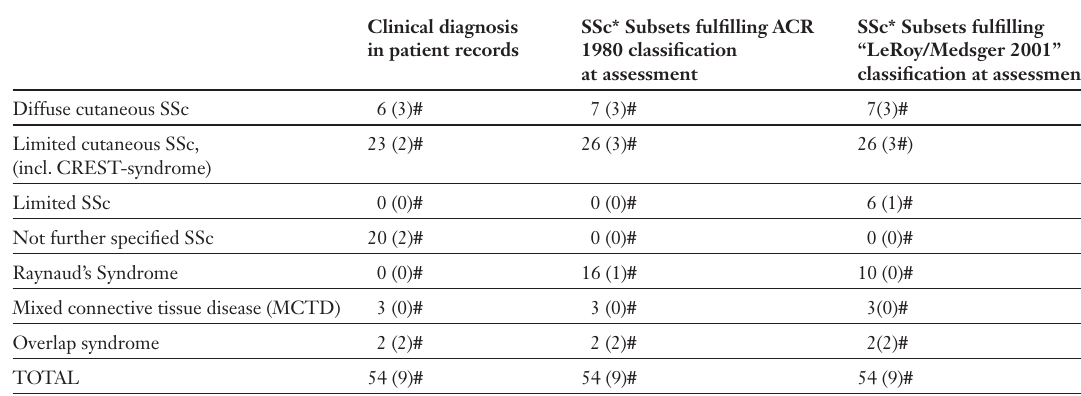
Diagnosis at first visit and ACR 1980